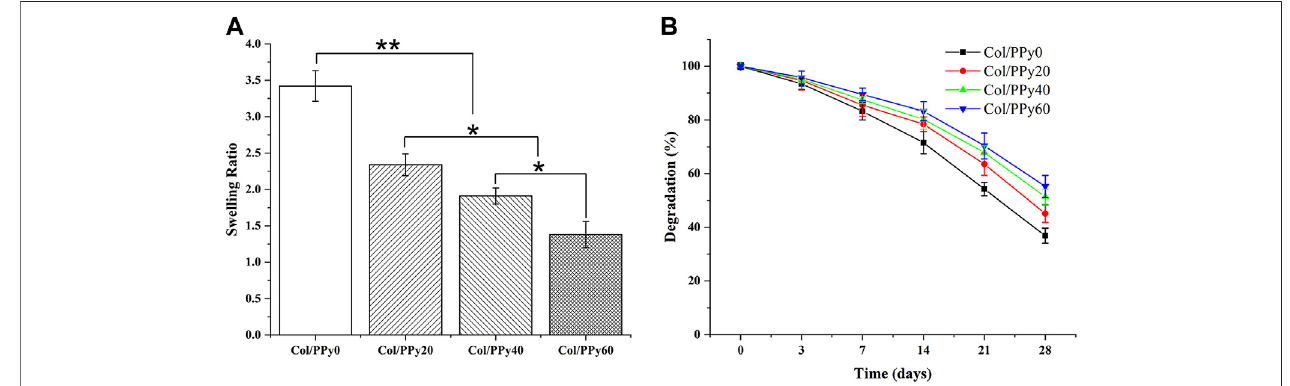
FIGURE 3 | Swelling properties (A) and degradation curves (B) of Col/PPy